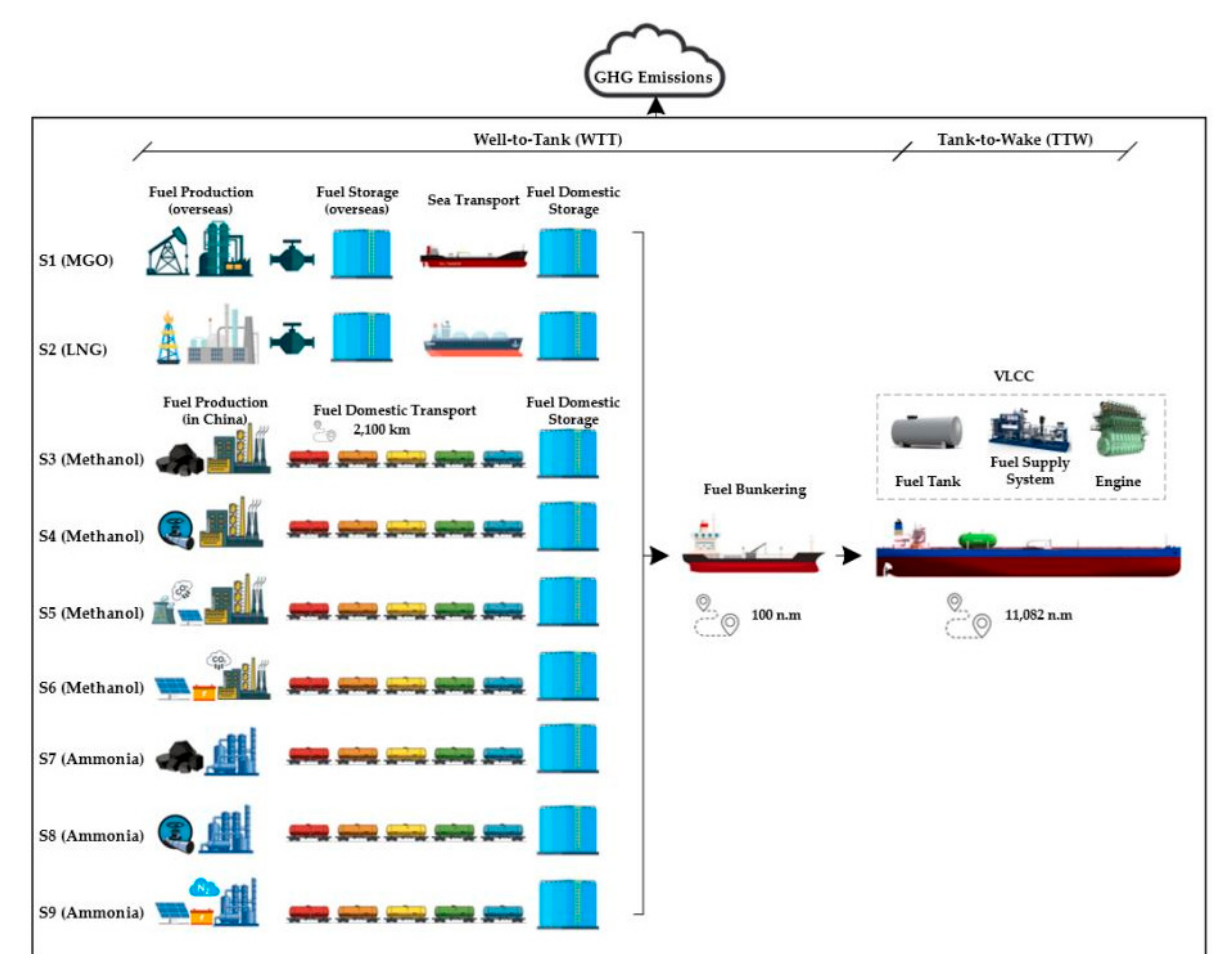
Figure 3. Supply chains of the